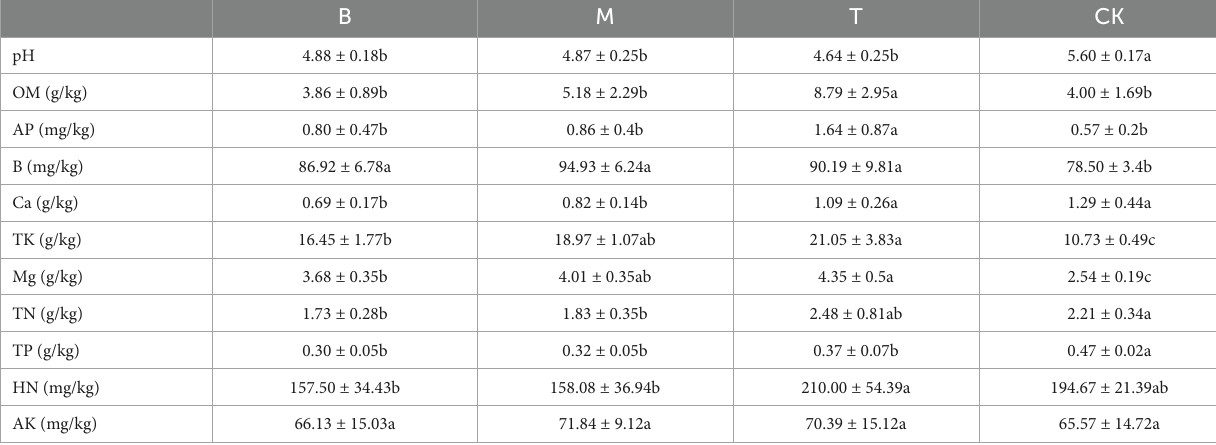
Data are given as mean ± SD. B, bottom slope; M, middle slope; T, top slope. Values in the columns followed by the same letter(s) are not significantly different ( p < 0.05) according to one-way